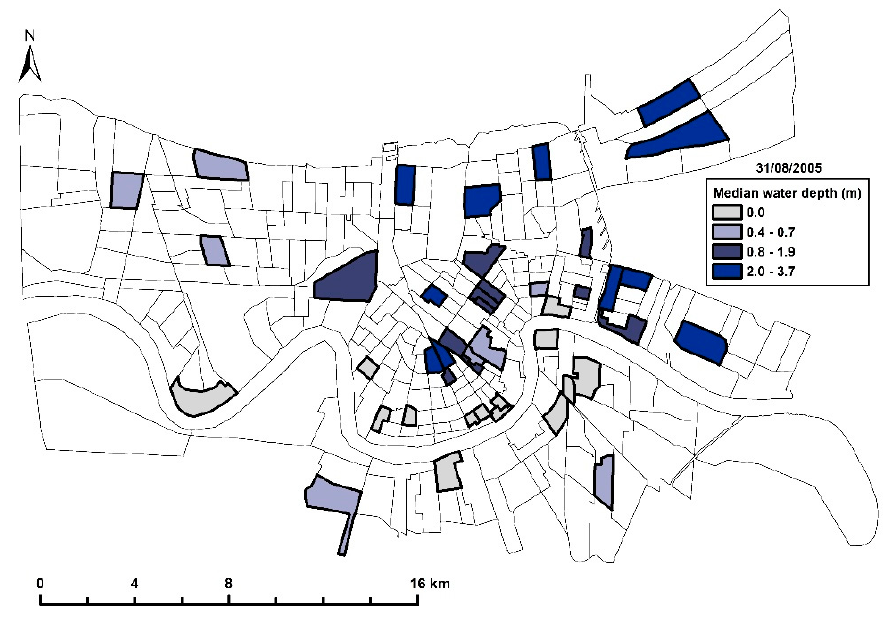
Figure 2. Map of the 44 census tracts in this study showing median flood water depth from Hurricane Katrina (31 August 2005).